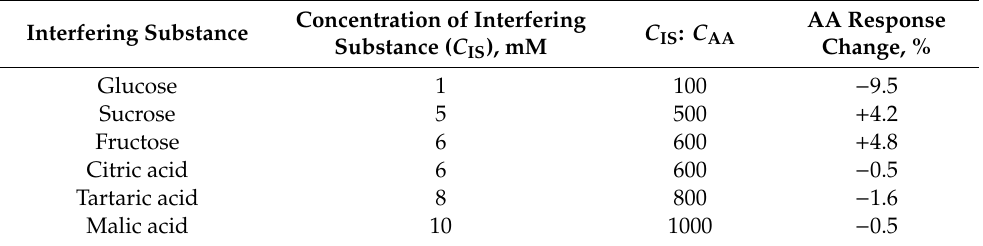
Table 2. Interfering effect of some substances on AA response (AA response at С AA = 0.01 mM taken as 100%).